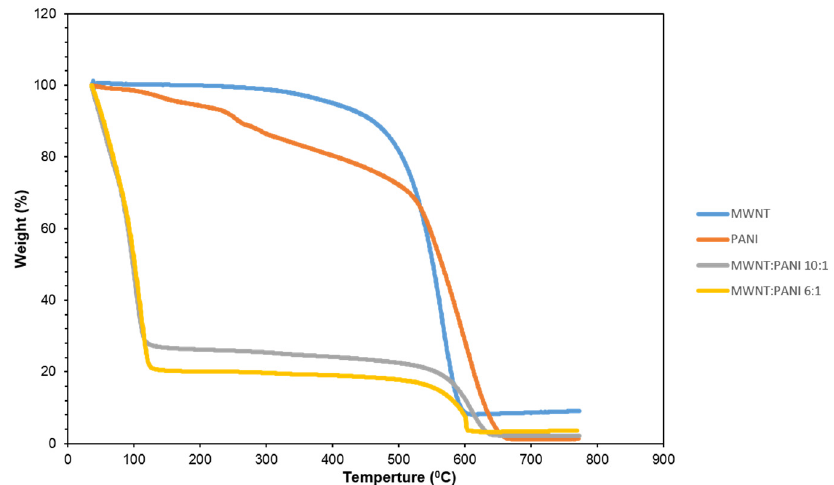
Figure 9. TGA results of MWCNT only (blue); PANI only (orange); MWCNT/PANI at a ratio of 10:1 (gray); MWCNT/PANI in ratio of 6:1 (yellow).